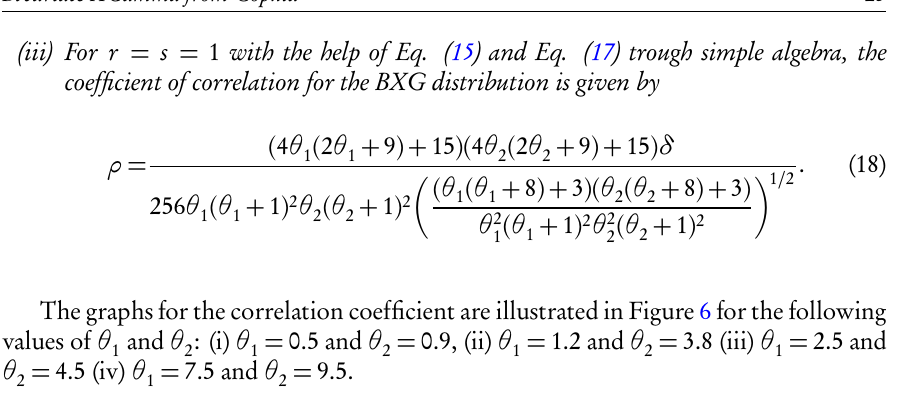
Figure 6 – The correlation cofficient ρ of θ